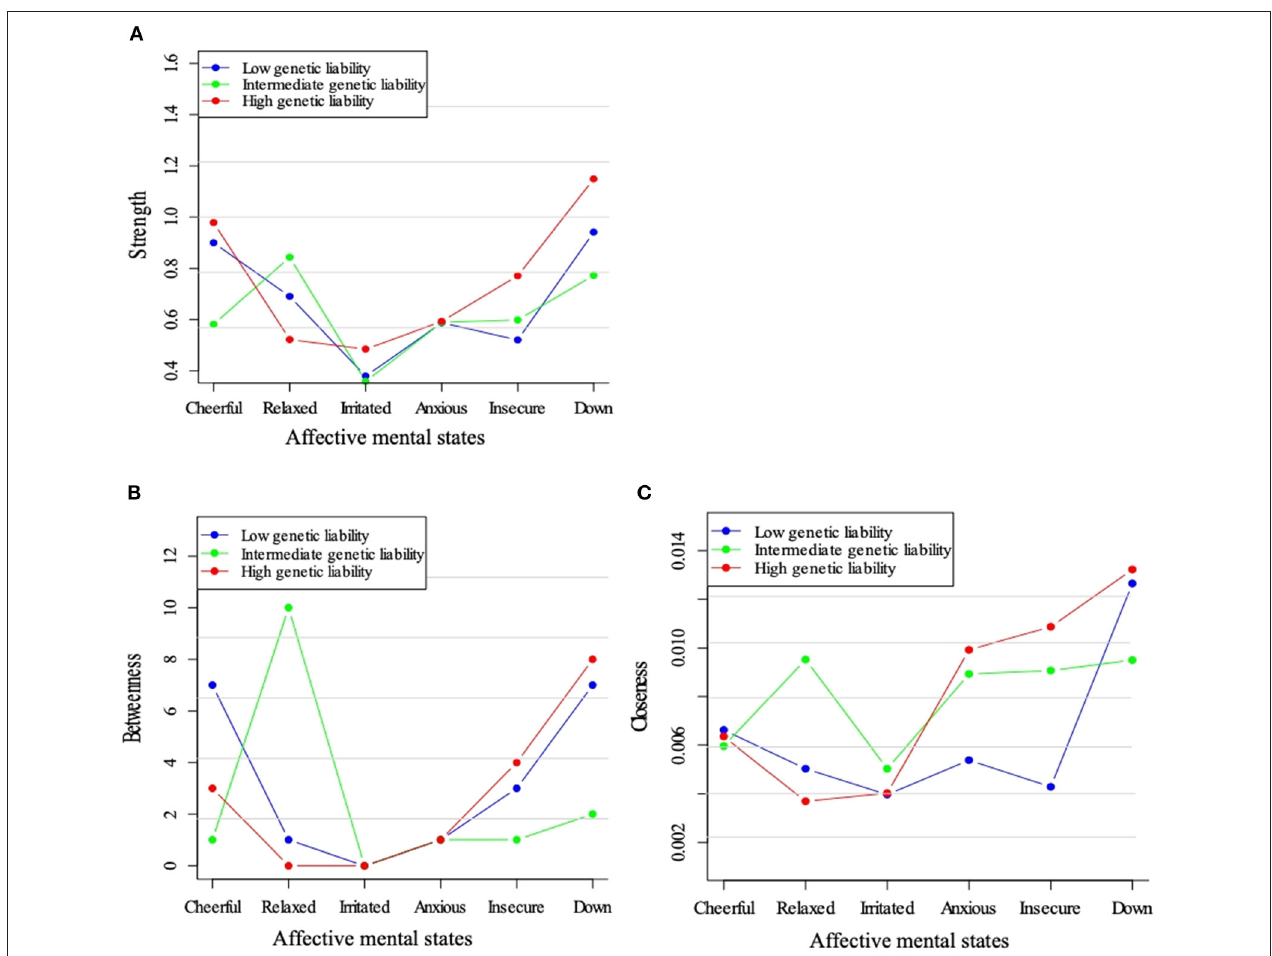
FIGURE 4 | Centrality measures for the networks across levels of genetic liability for psychopathology . Three node centrality measures: Strength (A) , Betweenness (B) , and Closeness (C) , of low, intermediate, and high genetic liability for psychopathology networks.